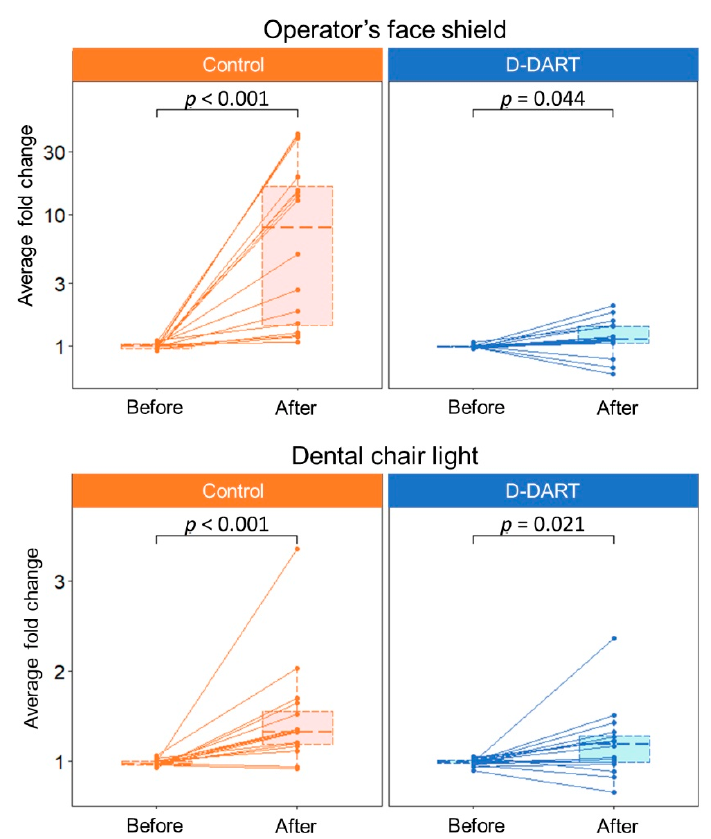
Figure 2. Contamination on the operator’s face shield and dental chair light before and after treatment without (orange, Control) or with the D-DART (blue). The D-DART was able to prevent the surface contamination of the face shield by aerosolized particles.